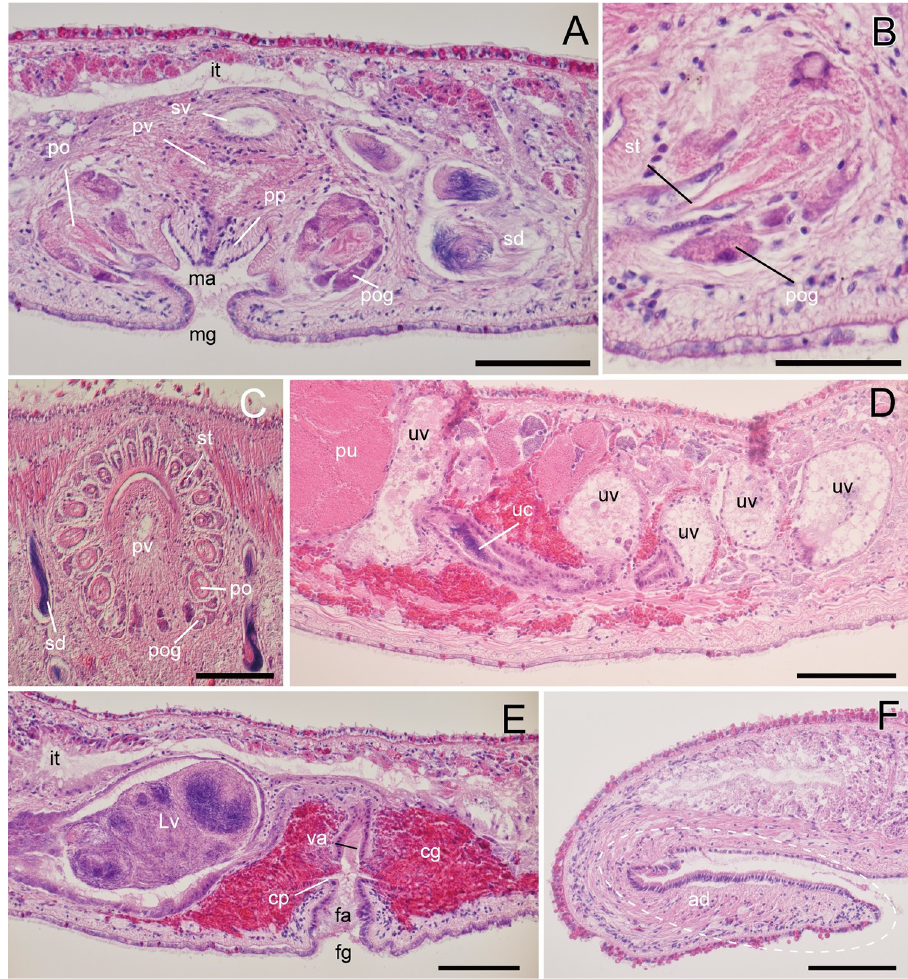
Fig 6. Boninia yambarensis sp. nov.: Photomicrographs of sagittal (A, B, D–G) and horizontal sections (C). (A) ICHUM 8284 (holotype), male copulatory apparatus, anterior to the right; (B) ICHUM 8284 (holotype), prostatoid organ, anterior to the right; (C) ICHUM 8285 (paratype), arrangement of prostatoid organs; (D) ICHUM 8284 (holotype), uterine vesicles, anterior to the right; (E) ICHUM 8284 (holotype), female copulatory apparatus, anterior to the right; (F) ICHUM 8284 (holotype), adhesive organ. Abbreviations: ad, adhesive organ; au, anterior dilation of uterus; cg, cement glands; cp, cement pouch; fa, female atrium; fg, female gonopore; it, intestine; Lv, Lang’s vesicle;